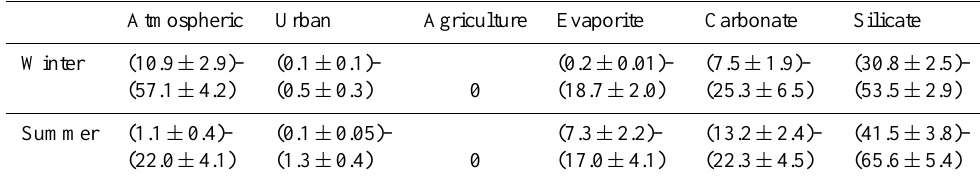
Table 7. The contributions of different sources to Sr in the Xishui River solved by an inversion